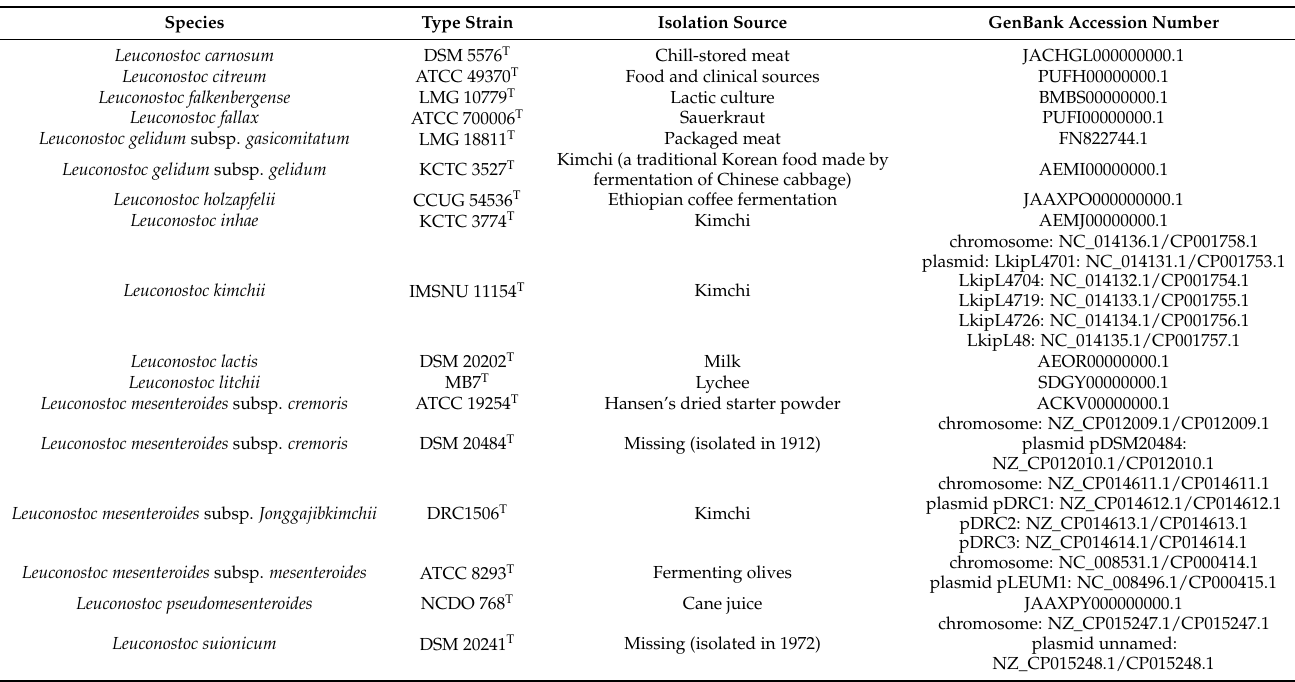
Table 1. Genome features of the 17 type-strains of the Leuconostoc genus analyzed in this study. The genome sequences of the type strains of L. gelidum aenigmaticum LMG 27840 T , L. miyukkimchii DSM 25624 T , L. palmae DSM 21144 T , L. rapi DSM 27776 T are not publicly